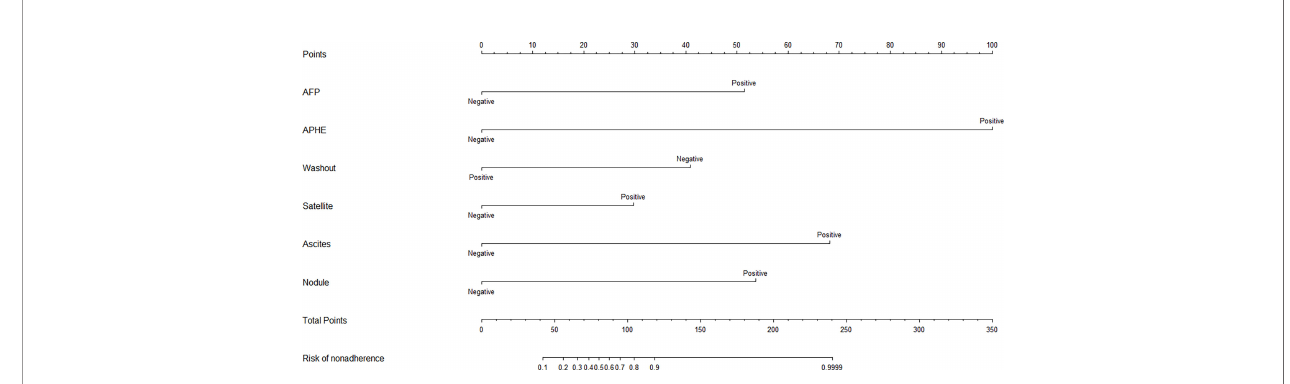
FIGURE 3 | Based on the independent factors, the nomogram analysis method was used to establish a prediction scoring system. To use the nomogram, fi nd the score for each variable on the corresponding axis and the total scores for all of the variables, and draw a line from the total score axis to the malignant risk axis to